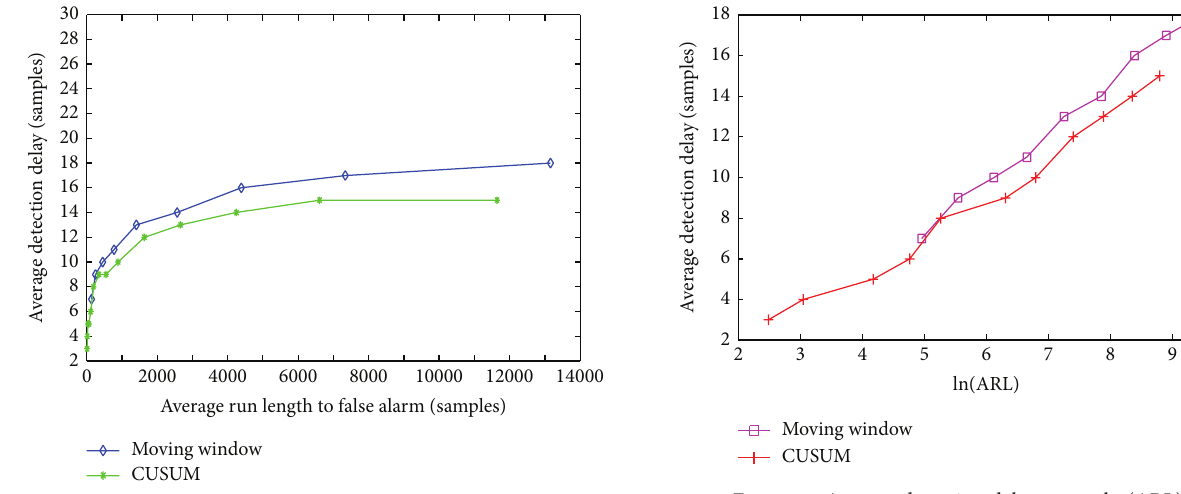
Figure 4: Average detection delay versus average run length to false alarm.